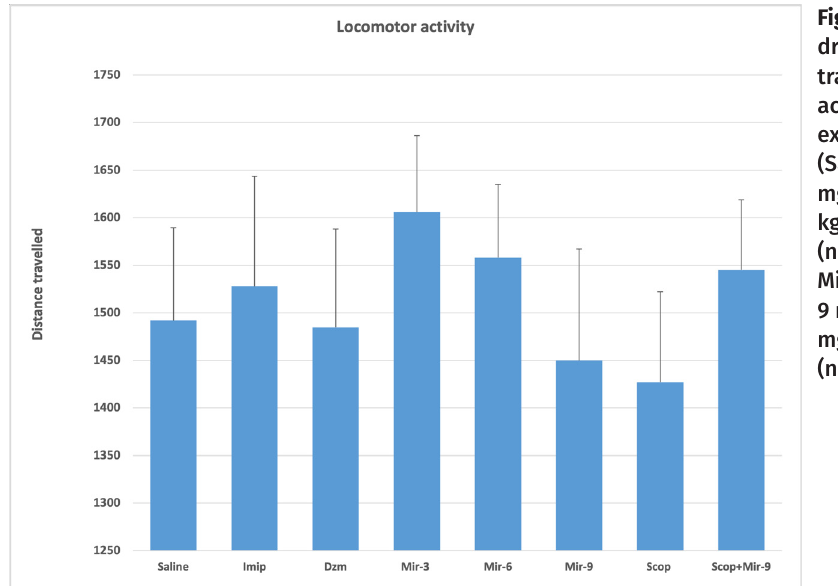
Figure 5. Effect of drugs on total distance traveled in locomotor activity test. Data